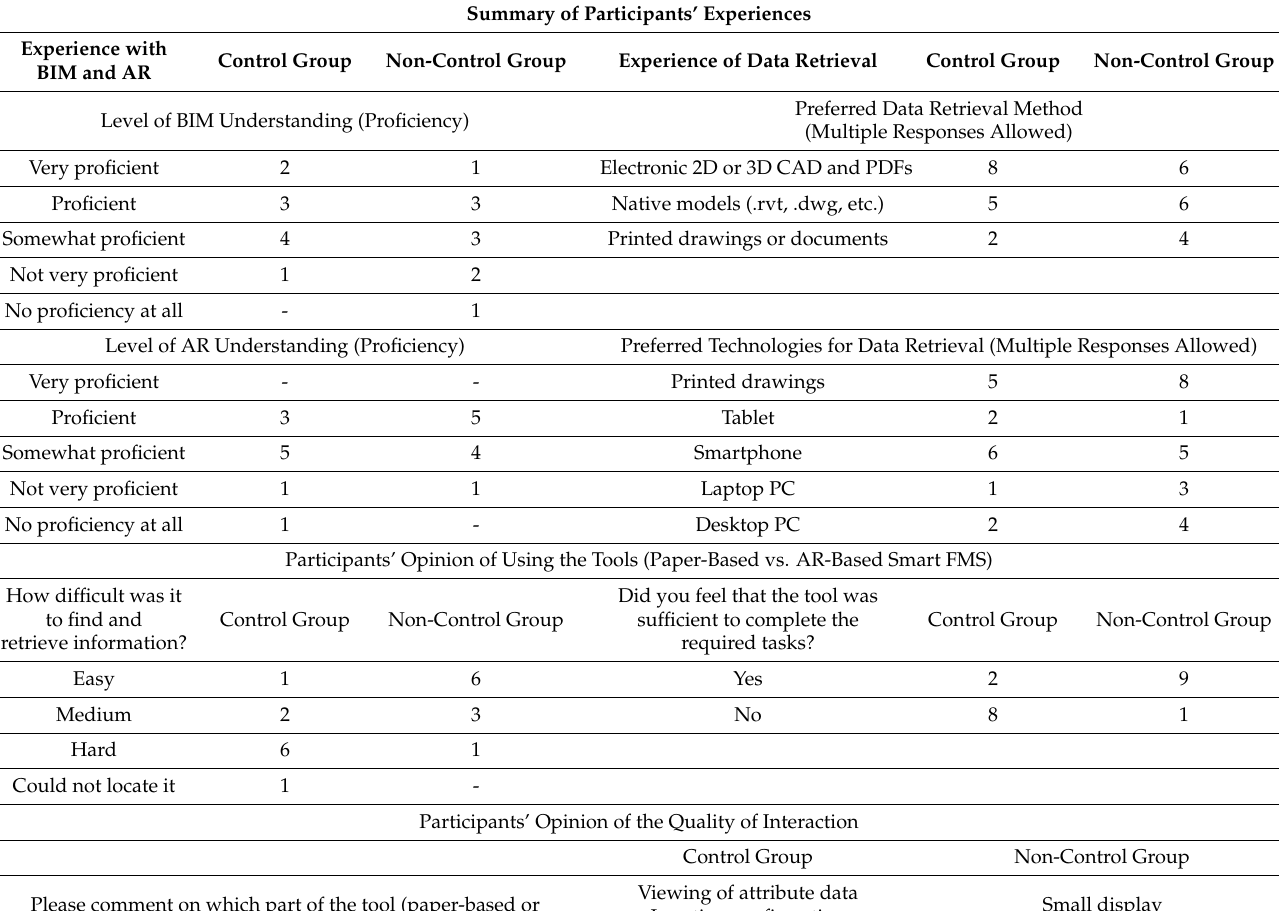
Table 3. Survey summary of test